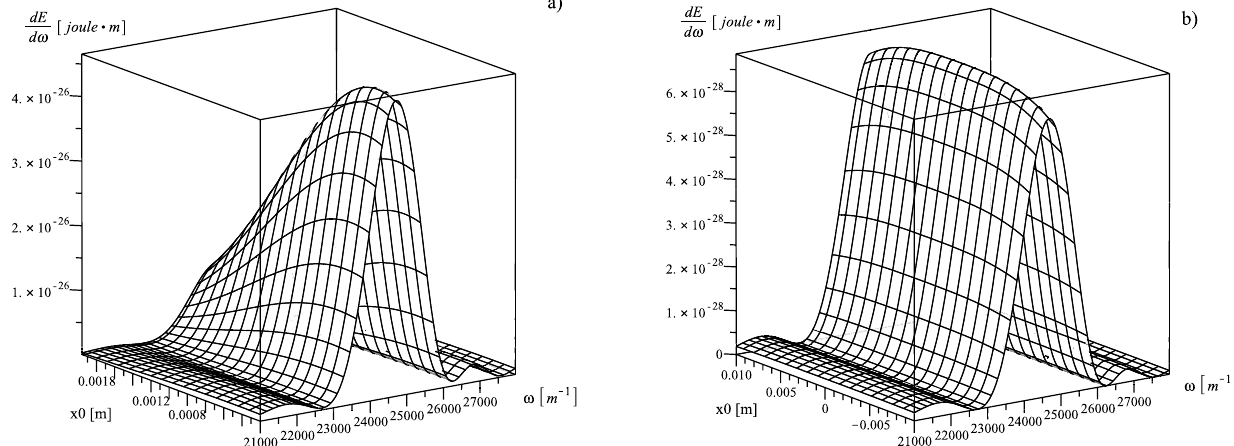
Figure 2. Spontaneous emission spectra as a function of the beam centroid distance from the dielectric surface: ( a ) single slab waveguide geometry; and ( b ) double slab waveguide geometry.